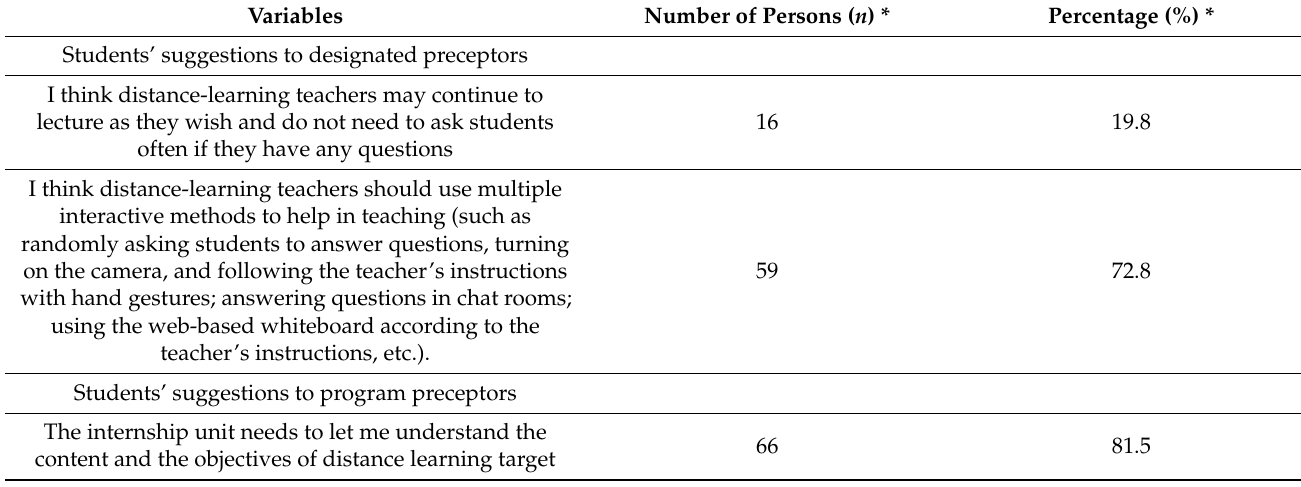
Table 3. Students’ suggestions regarding distance-learning components of internships.